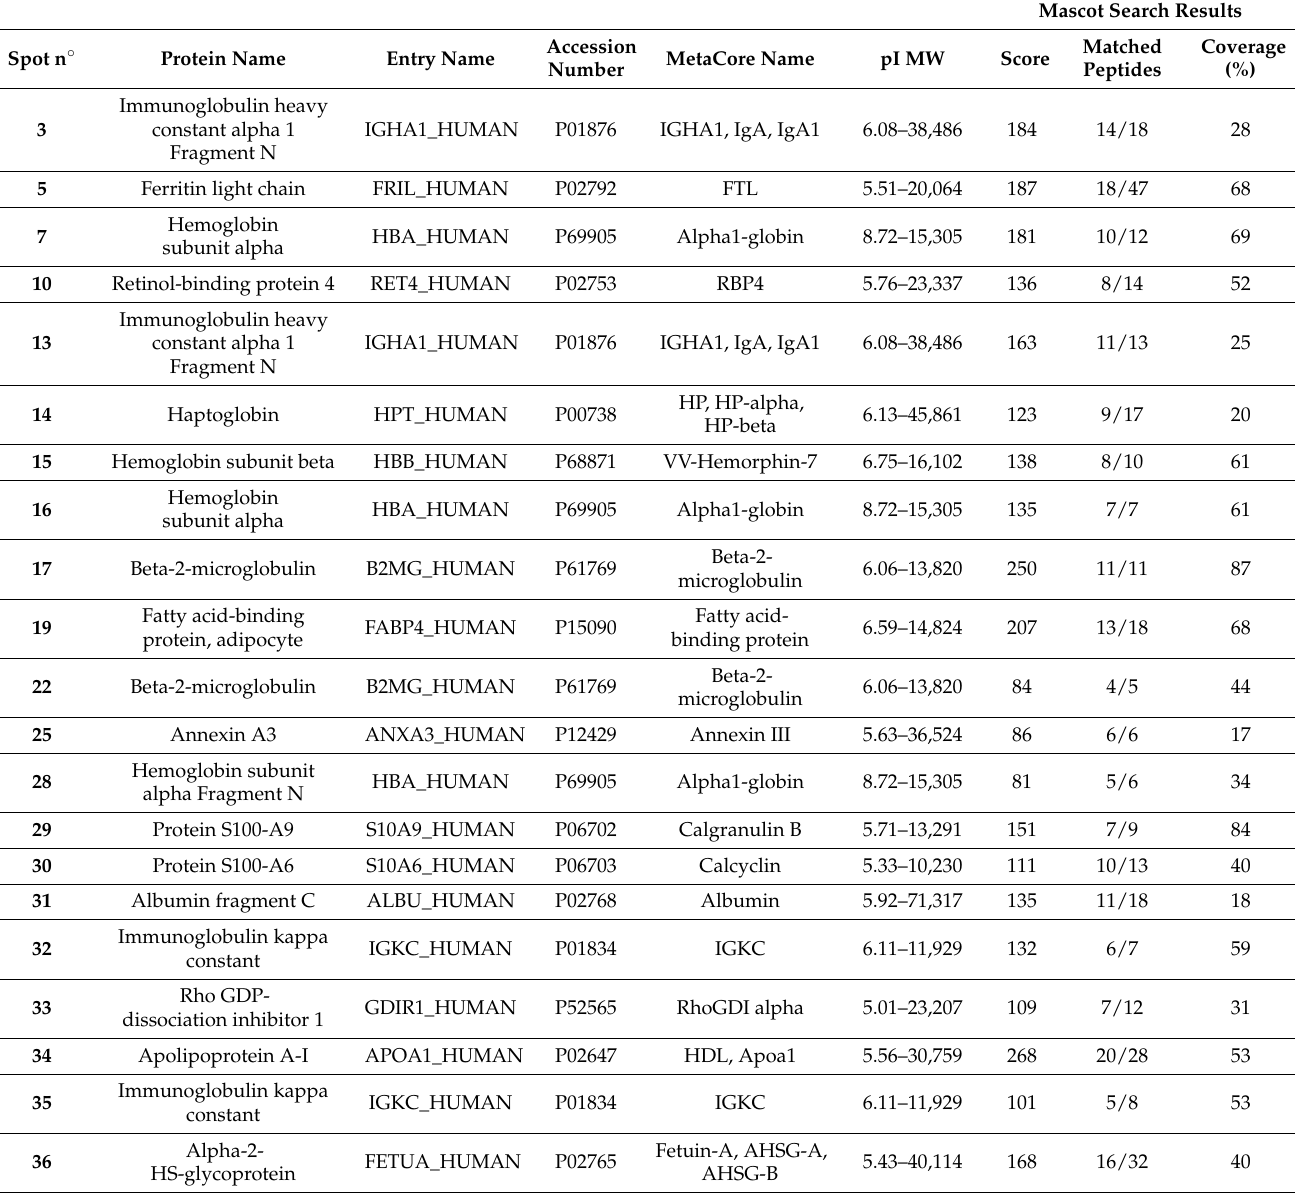
Table 2. Identification results by PMF of the statistically relevant spots, detected by proteomic analysis on BALF samples. Spot number, corresponding to that in Figures 1 and 2, UniProt protein name, entry name and accession number, MetaCore name, pI and MW and Mascot search results such as score, matched peptides, and coverage % were